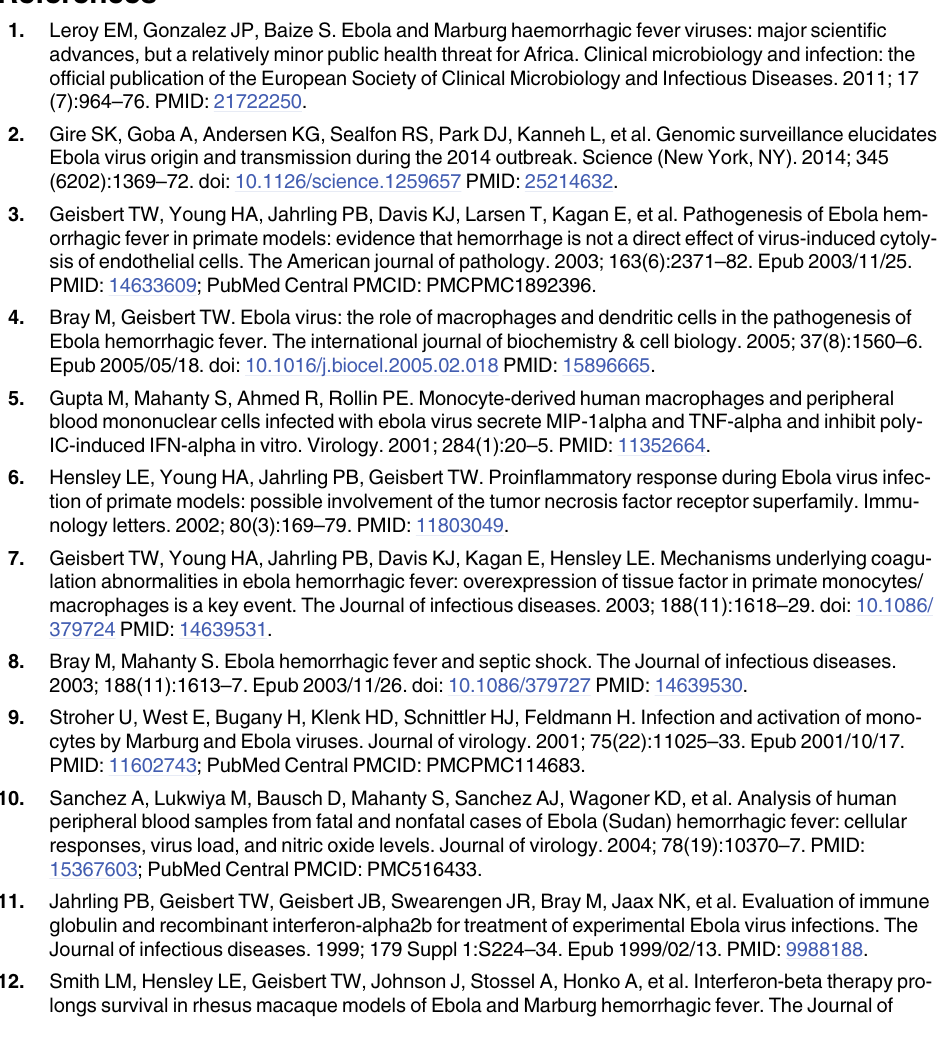
S2 Table. IFN γ stimulated genes significantly altered in human alveolar macrophages treated with 20 ng/ml of IFN γ as assessed by gene array analysis. ISGs that were assessed fur- ther in this study are